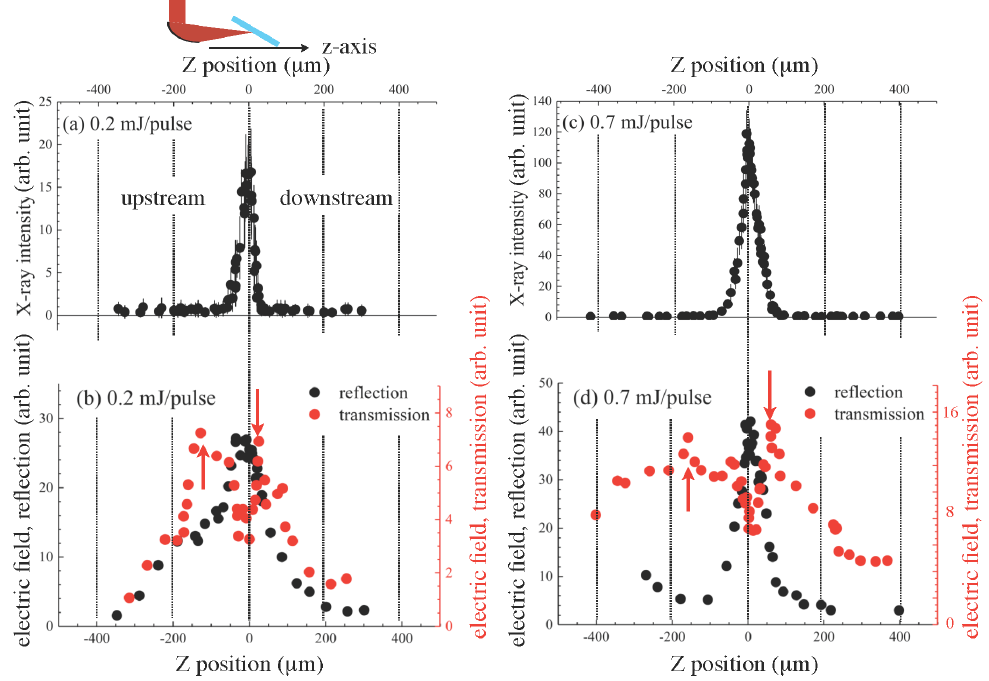
Figure 3. X-ray ( a ) and THz wave ( b ) intensities as a function of the flow position along the Z -axis when the laser intensity was 0.2 mJ/pulse and 0.7 mJ/pulse ( c , d ); Red arrows in ( b , d ) for the transmission indicate the Z-positions at ( b ) − 135 µ m and 24 µ m ( ∆ z 1 = 159 µ m) and ( d ) − 167 µ m and 62 µ m ( ∆ z 2 = 229 µ m),